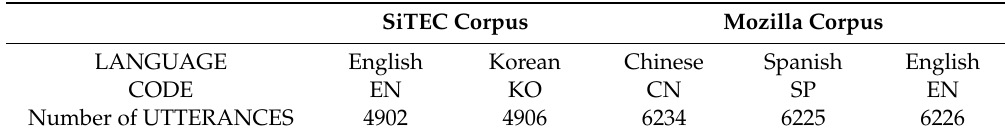
Table 2. Description of speech corpora used for evaluation. SiTEC: Speech information TEchnology & industry promotion Center.